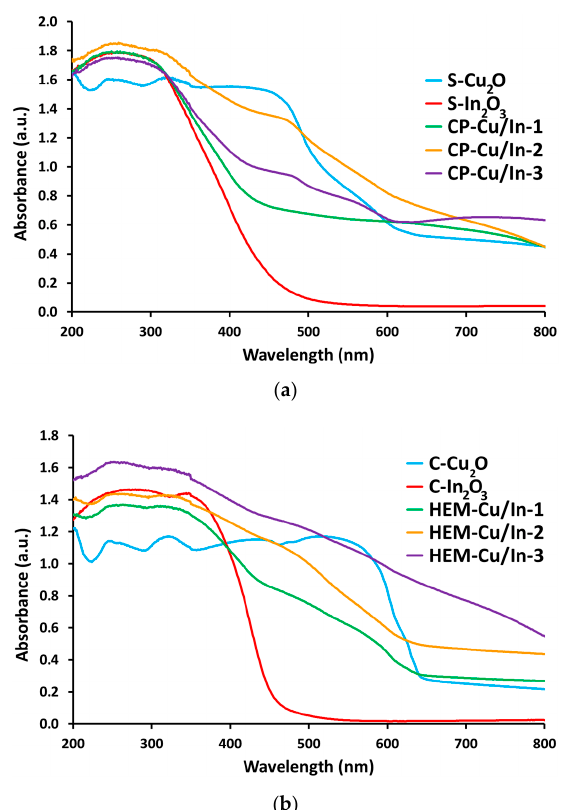
Figure 4. UV-Visible Diffuse Reflectance Spectroscopy (UV-VIS DRS) for Cu/In mixed oxides